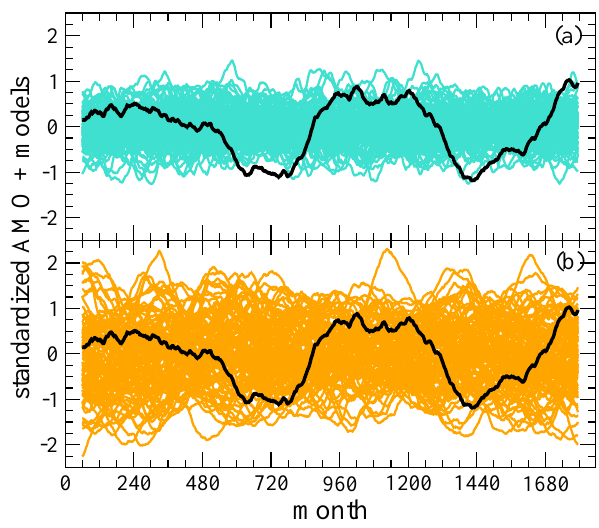
Fig. 7. Smoothed (121-point running mean) curves for (a) fitted AR(1), and (b) lrc model segments (thin coloured lines) after stan- dardisation. The heavy black curve is the same for the standardised monthly AMO series (also shown in Fig. 1).